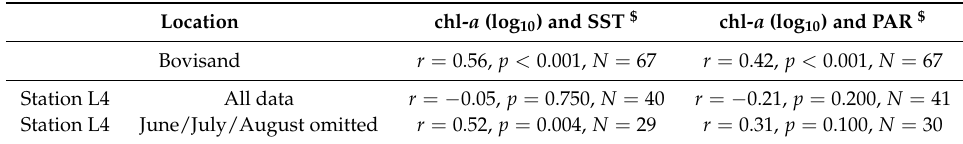
Table 1. Results from correlation coefficient analysis (Spearman’s) between chl- a and the physical variables (SST and PAR), including omission of summer months represented by the yellow shaded area in Figures